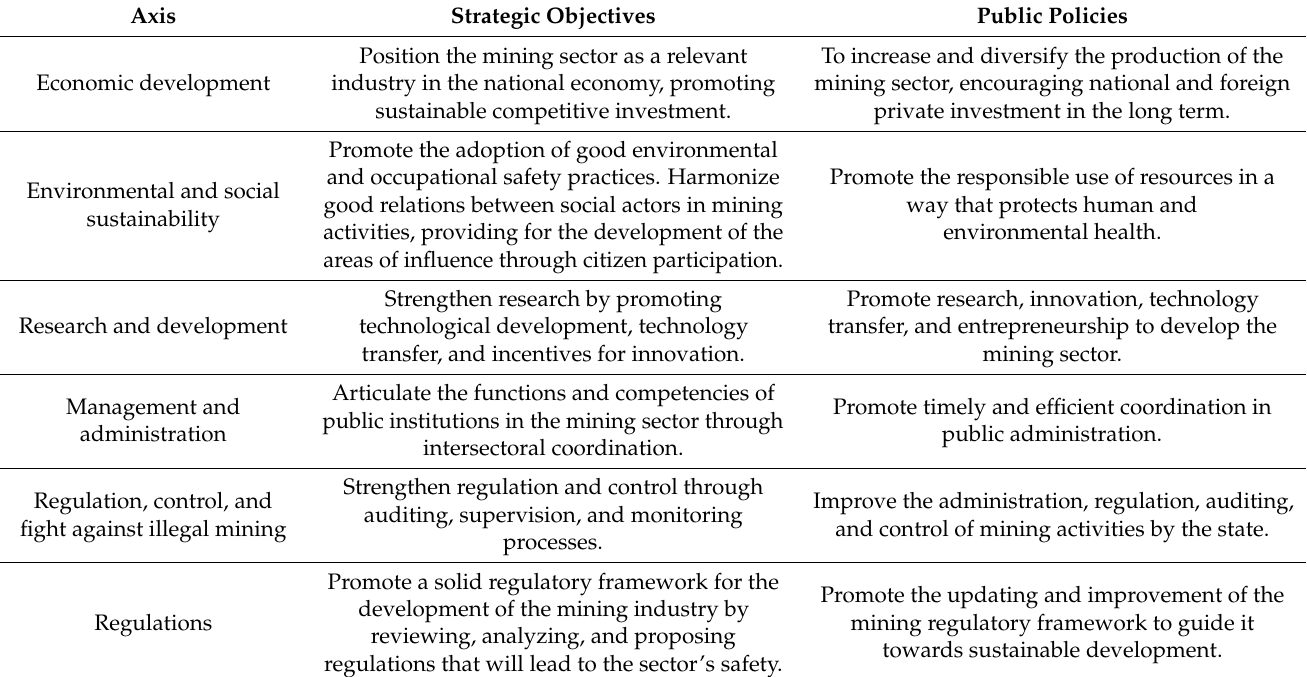
Table 5. Mining public policy